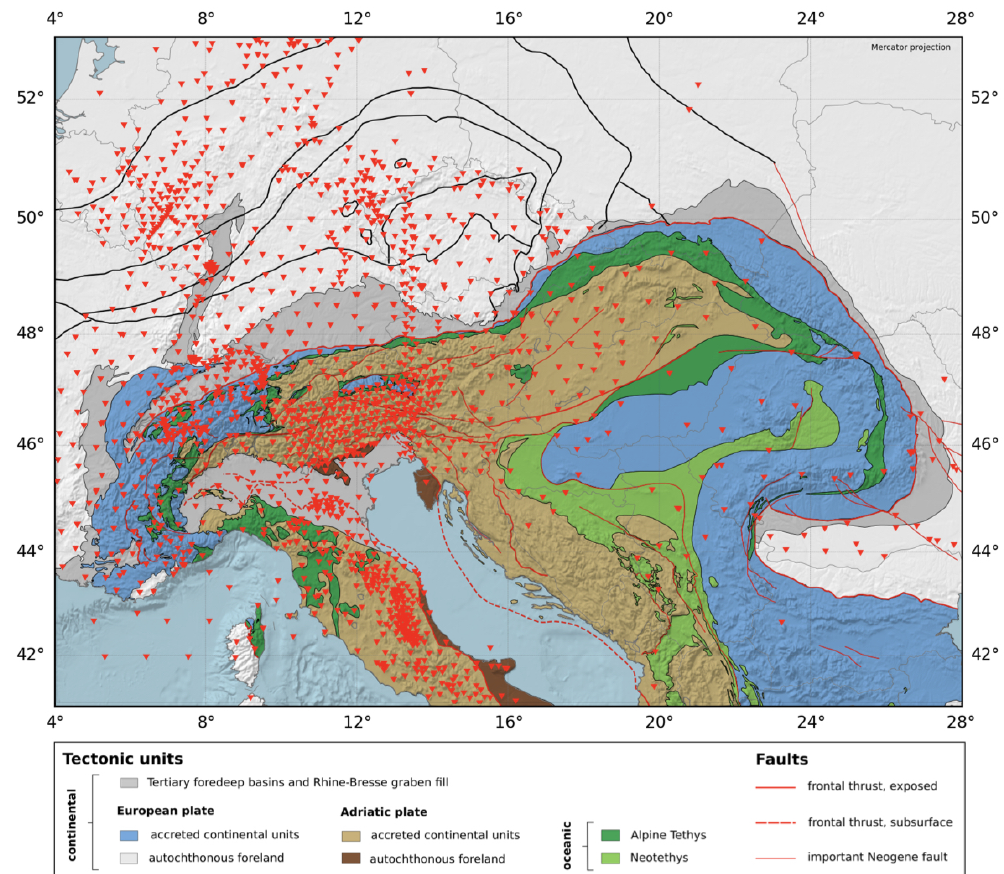
Figure 1. Distribution of permanent and temporary broadband stations used in this study (inverted red triangles) on a geological map of the area (following Hetényi et al., 2018a; their Fig.